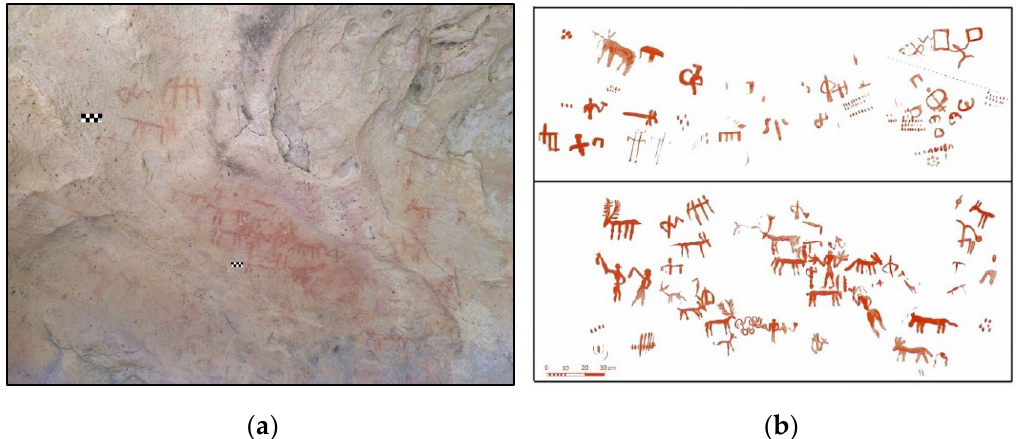
Figure 3. ( a ) State of conservation of some of the motifs painted in the main shelter of Bacinete with scales added (photograph by M. Díaz-Andreu, Artsoundscapes Project, 2021); and ( b ) record of some of the scenes in the main shelter by Breuil [25] (Plate XXVII).